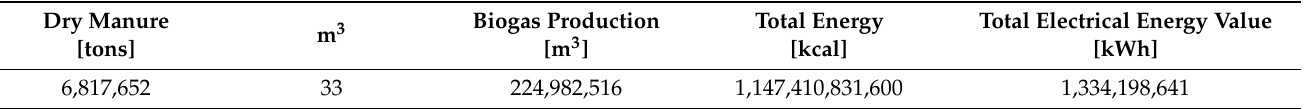
Table 8. Potential electricity generation from